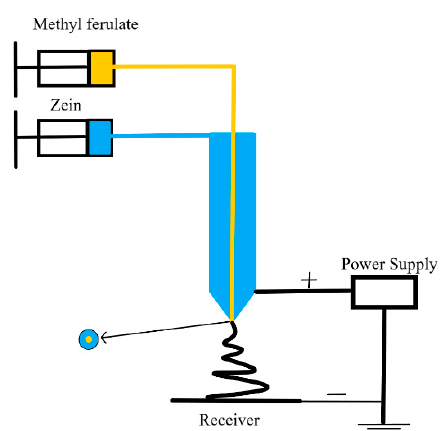
Figure 1. Schematic diagram of coaxial electrospinning